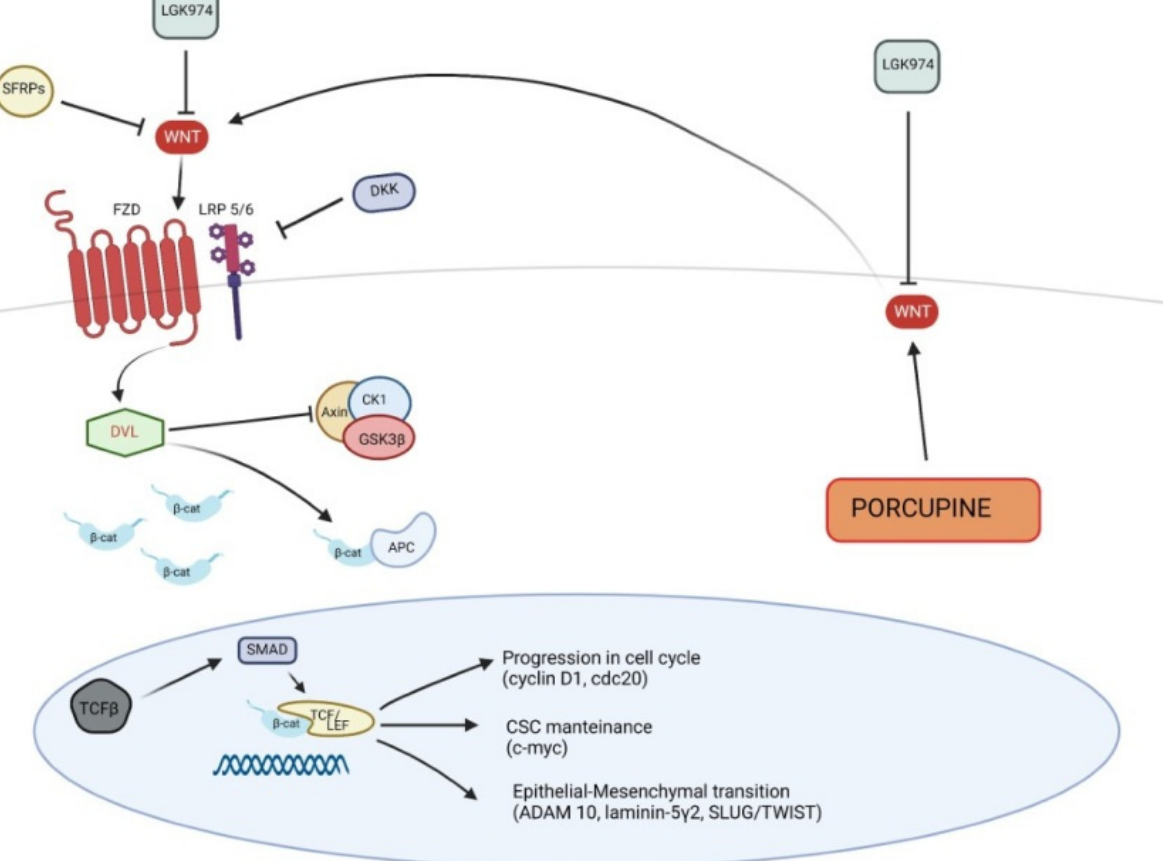
Figure 3. Canonical Wnt signaling pathway in pathogenesis of squamous cell carcinoma. SFRPs, secreted Frizzled-related proteins; DKK, Dickkopf; TGF- β , Transforming Growth Factor- β . CDC20 is a regulator of cell cycle, promoting the progression from metaphase